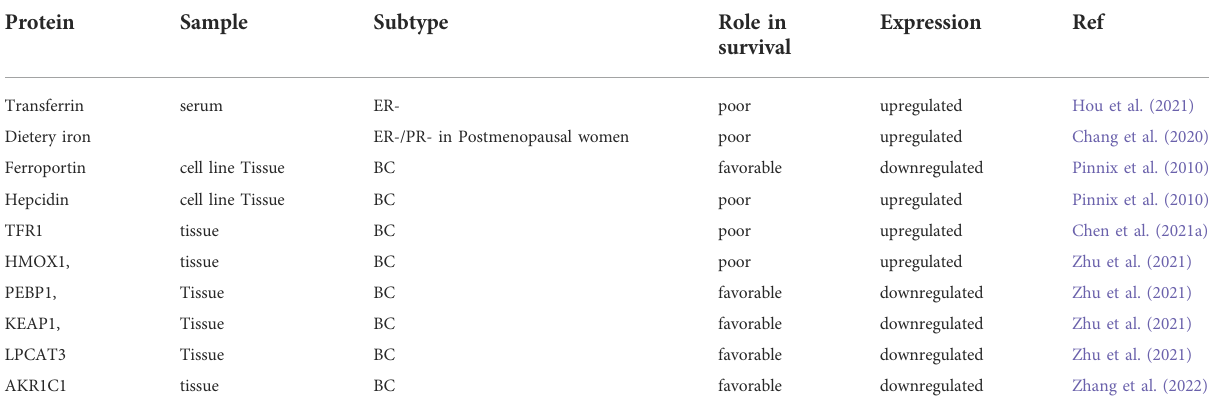
TABLE 1 The iron and iron-regulatory proteins related with the prognosis of breast